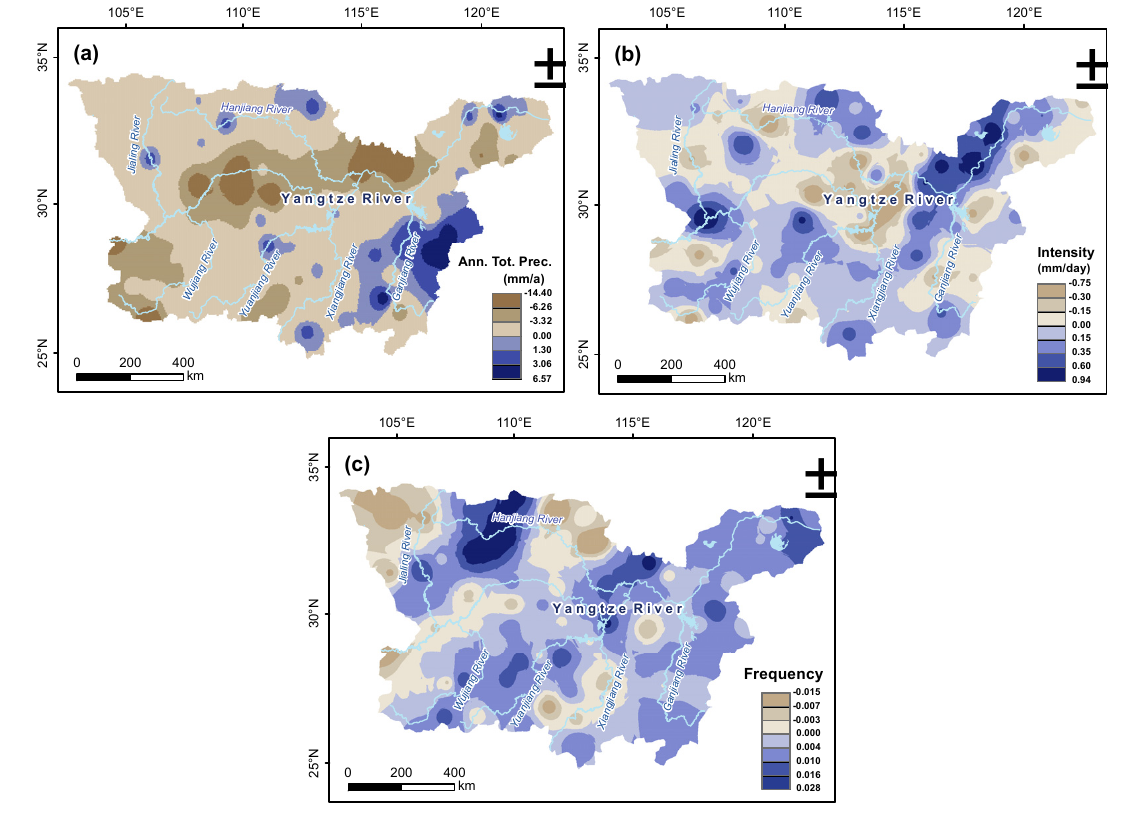
Figure 3. Spatial distribution of temporal trends in ( a ) annual total precipitation, ( b ) extreme precipitation intensity and ( c ) extreme precipitation frequency in the MLR-YR from 1982 to 2012.